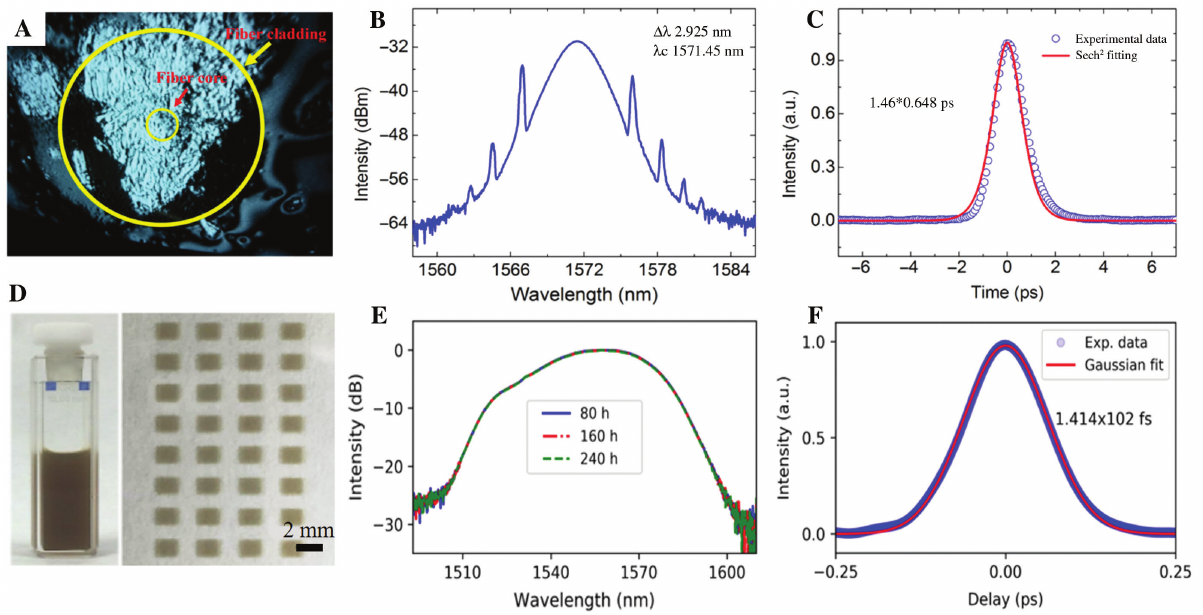
Figure 6: Typical mode-locked erbium-doped fiber lasers (EDFLs) by black phosphorus (BP) saturable absorbers (SAs). (A) Optical image of BP on fiber facet. (B) Pulse spectrum. (C) Autocorrelation traces. Reproduced with permission [153]. Copyright 2015, The Optical Society. (D) Photograph of BP dispersion and inkjet-printed BP SA arrays. (E) Spectra of mode-locked pulse acquired after 80 h, 160 h and 240 h. (F) Autocorrelation traces. Reproduced with permission [154]. Copyright 2018, The Optical Society.